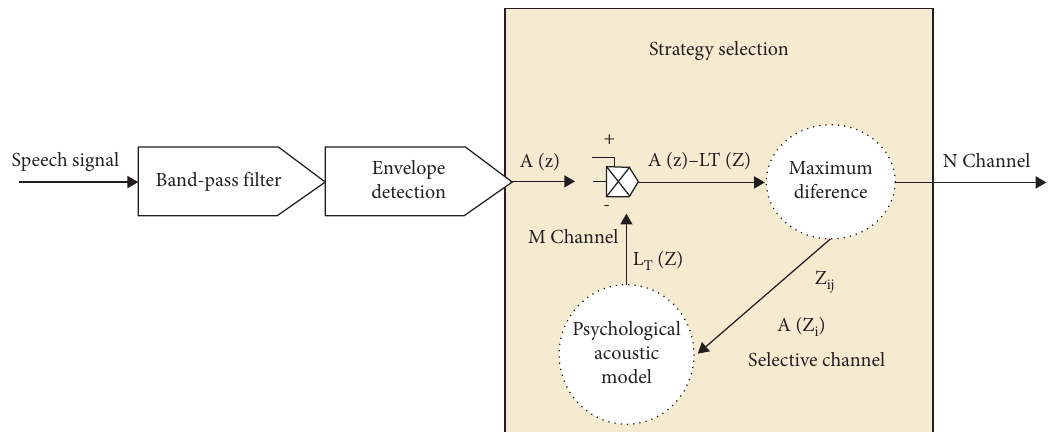
Figure 11: Channel selection.